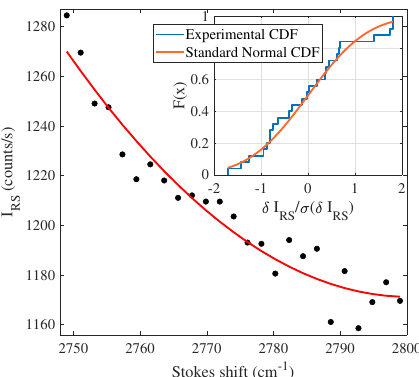
Figure 3. The high-energy tail of the 2D peak (black points) was fitted to the polynomial of the 2nd order (red curve) to determine the experimental error. The normality of the residuals is tested by the Kolmogorov-Smirnov test (inset).